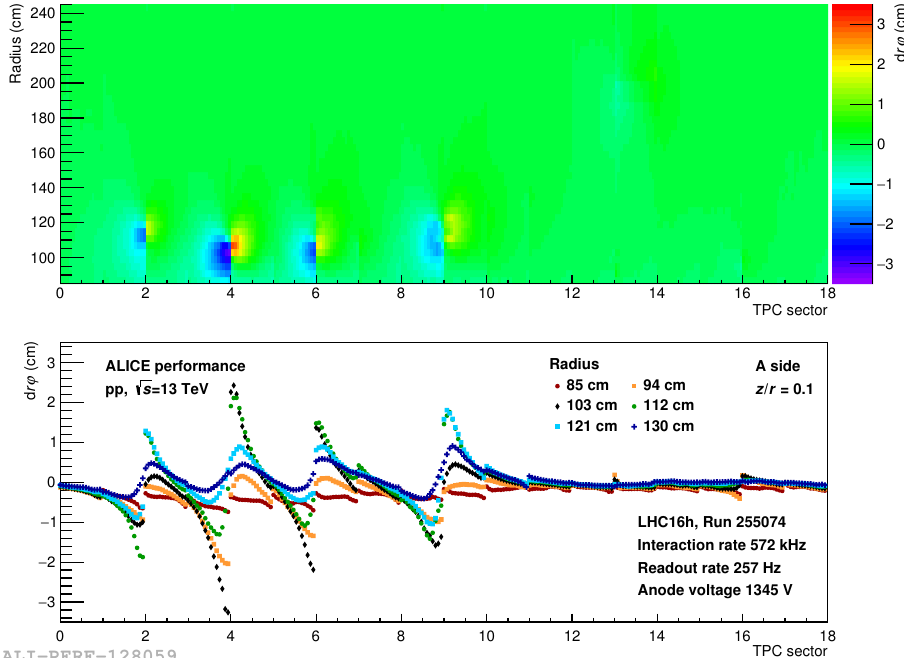
Figure 9. Upper panel: the deviations on the reconstructed points induced by local space charge distortions in the TPC as a function of the radius and TPC sector (which is a 20-degree wide azimuthal region) for the A side. Lower panel: large local deviations of up to 3 cm are observed at the TPC sectors; 2, 4, 6, 7 and